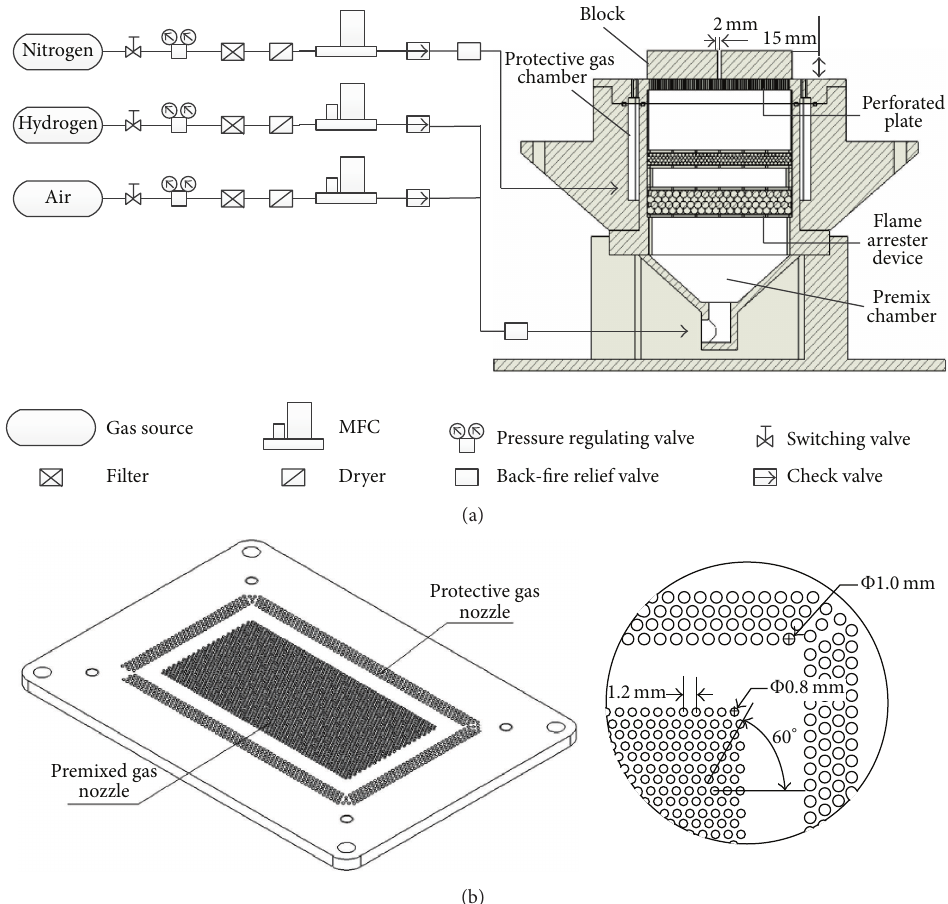
Figure 5: Schematics of the combustion system: (a) burner and its gas supply system; (b) arrangement of the circular nozzles.